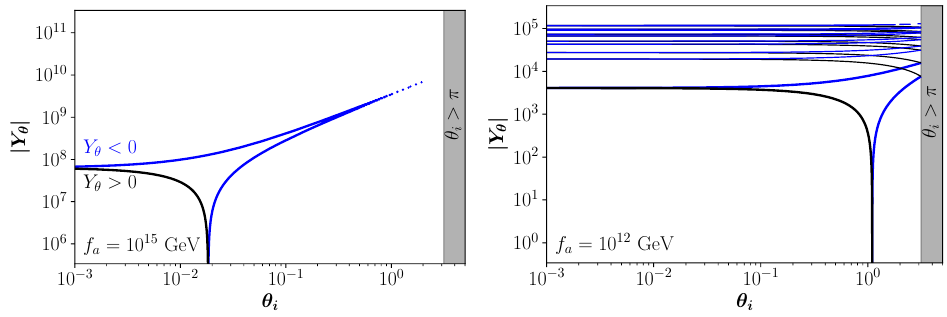
Figure 3. Kinetic misalignment. Parameter space that reproduces the whole observed DM abundance for f a = 10 15 GeV ( Left ) and f a = 10 12 GeV ( Right ). Black and blue lines correspond to Y θ > 0 and Y θ < 0, respectively.